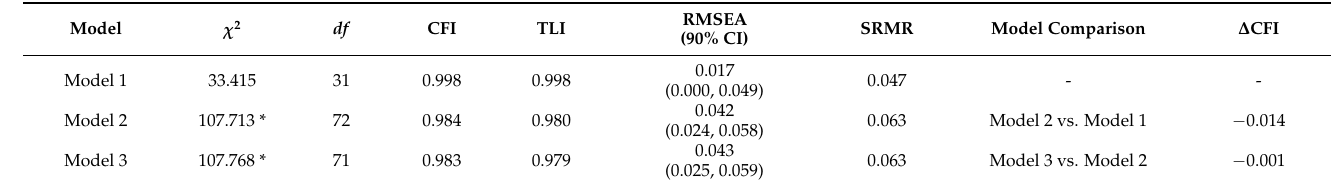
Table 3. Fit indices of the models tested.